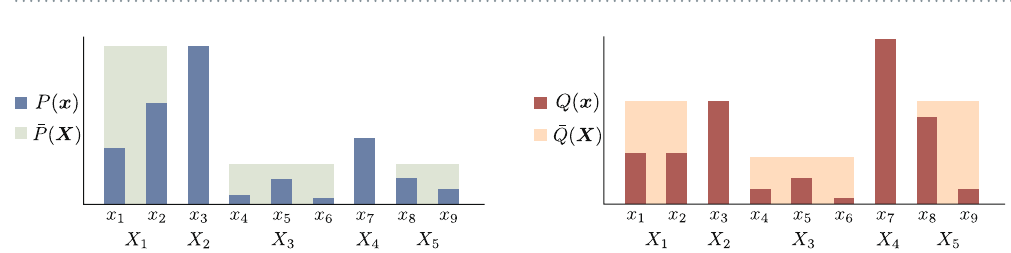
Figure 7. Schematic of the shapes of the error functions. As long as the gap between two error functions is nondecreasing, the error with the smaller value does not saturate earlier than the other.